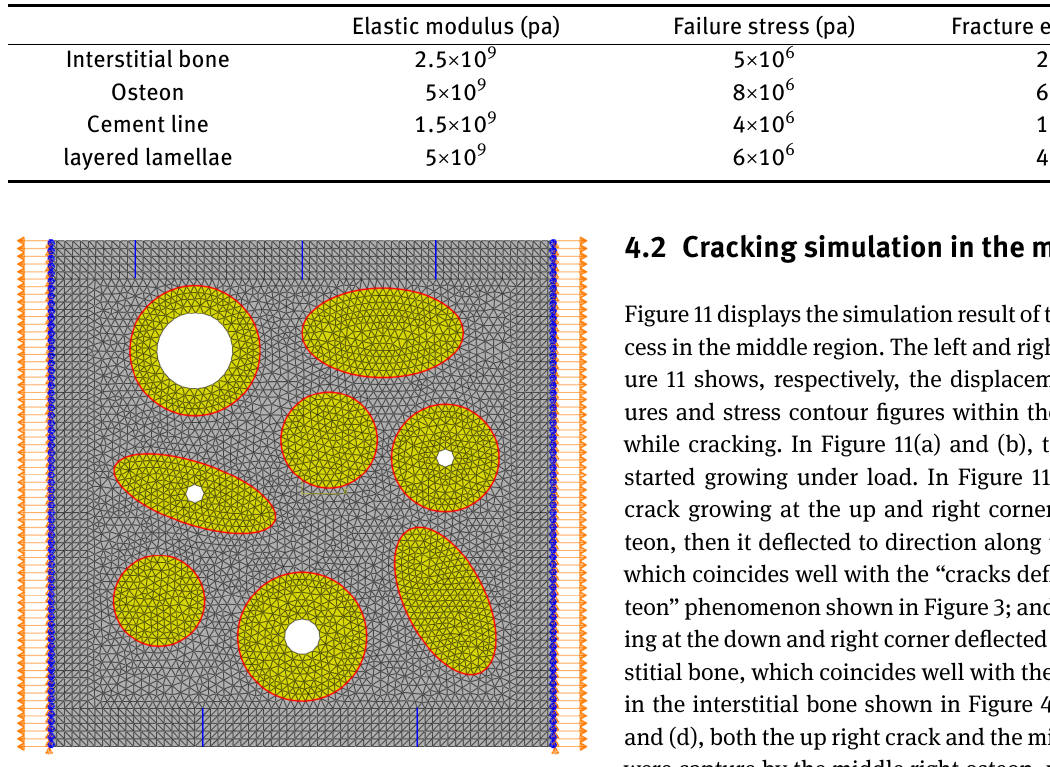
Figure 9: The 2D FEM model of the middle region of the cortical bone. The interstitial bone is colored to gray, the osteons is colored to yellow, the red circles represent the cement line around the osteon, and the blue line marked out the